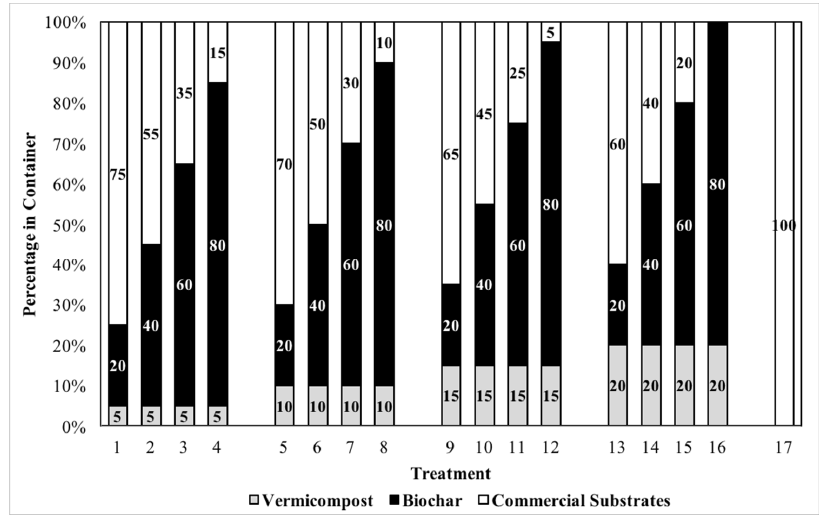
Figure 1. Seventeen formulated substrates including mixes of biochar (20%, 40%, 60%, or 80%, by volume) with vermicompost (5%, 10%, 15%, or 20%, by volume) and the 100% commercial peat-based substrates, Berger BM7 35BKS.